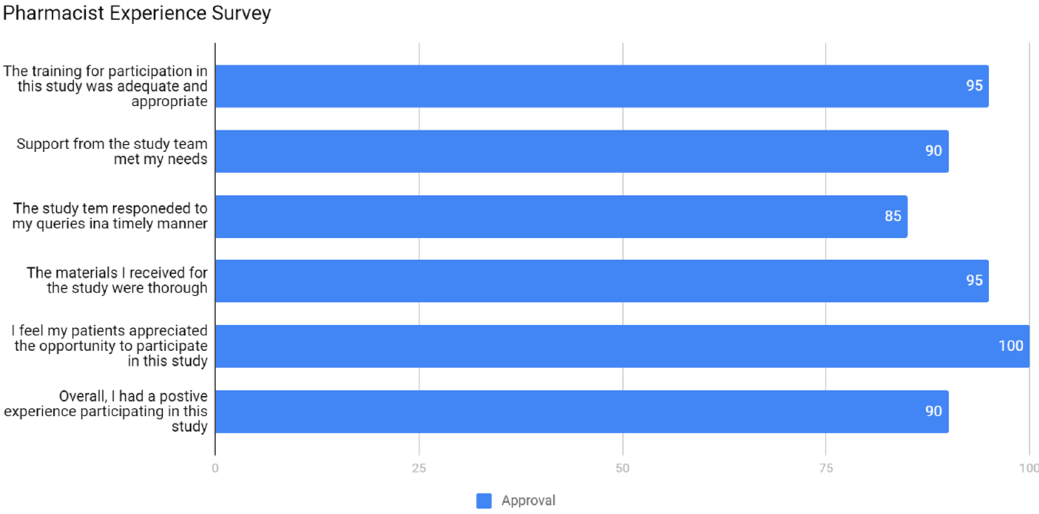
Figure 3. Pharmacist experience survey, 85–100% strongly agree or agree, N =